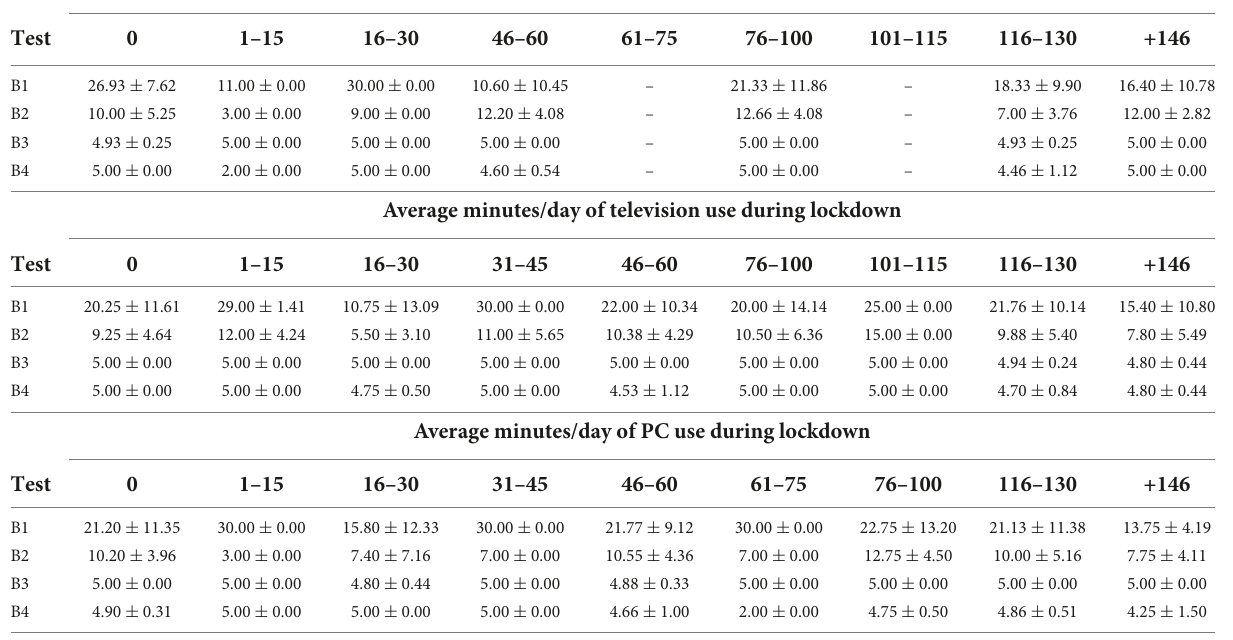
TABLE 3 The post-lockdown balance test results according to exposure to screens during lockdown using descriptive